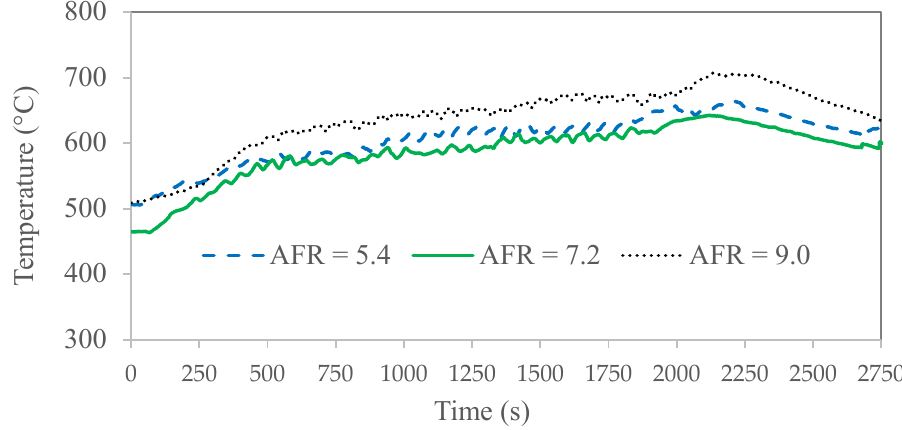
Figure 7. Trends in combustion chamber temperature on the lower side as determined by experi ‐ ment.